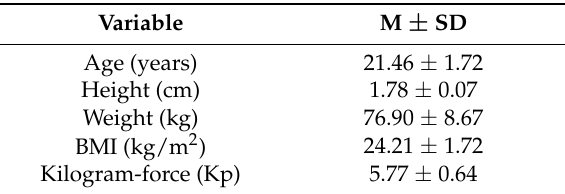
Table 1. Characteristics of the 15 study